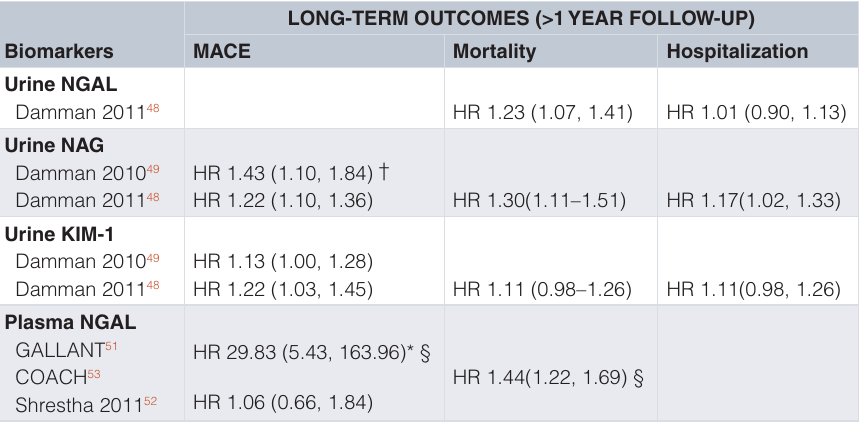
Table 3. Biomarkers of AKI and outcomes in cardiorenal syndrome.